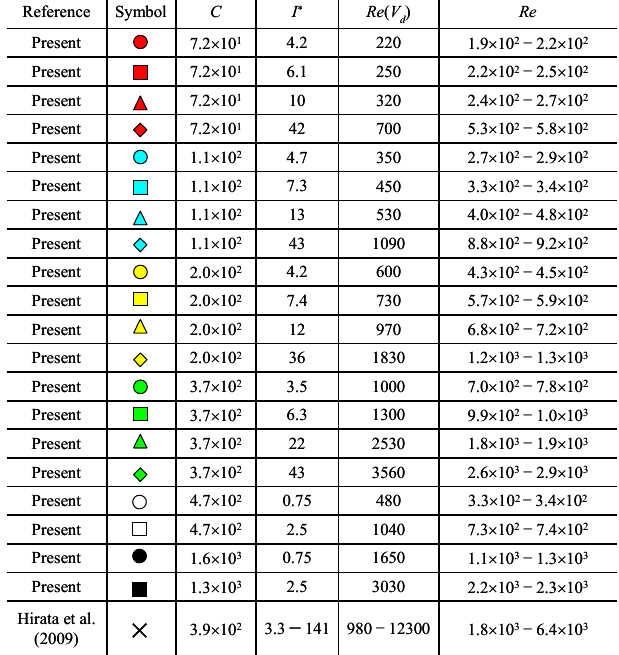
Table 2 Details of C , I * and Re ( V d ), together with corresponding symbols in Figs. 5 − 15. In all the present experiments, λ = 0.3 and AR =